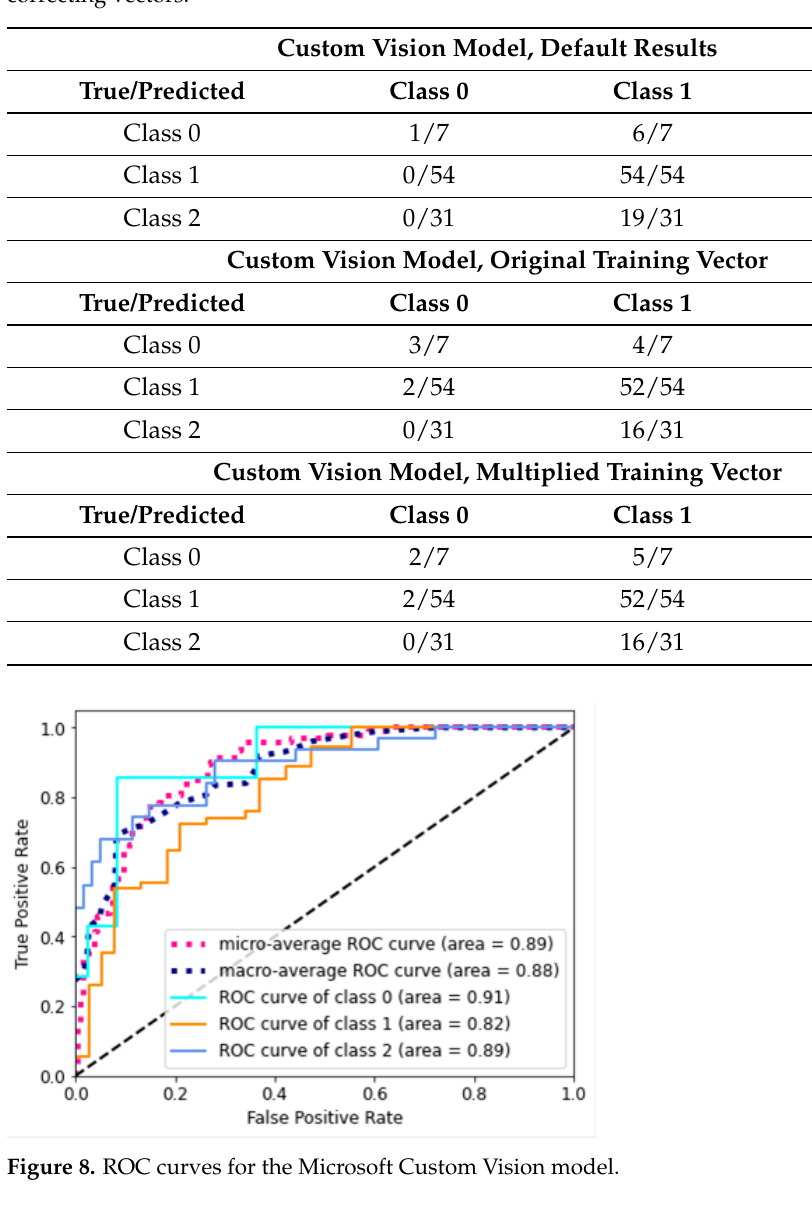
Table 11. Confusion matrices for the Custom Vision model on the validation set with different correcting vectors.